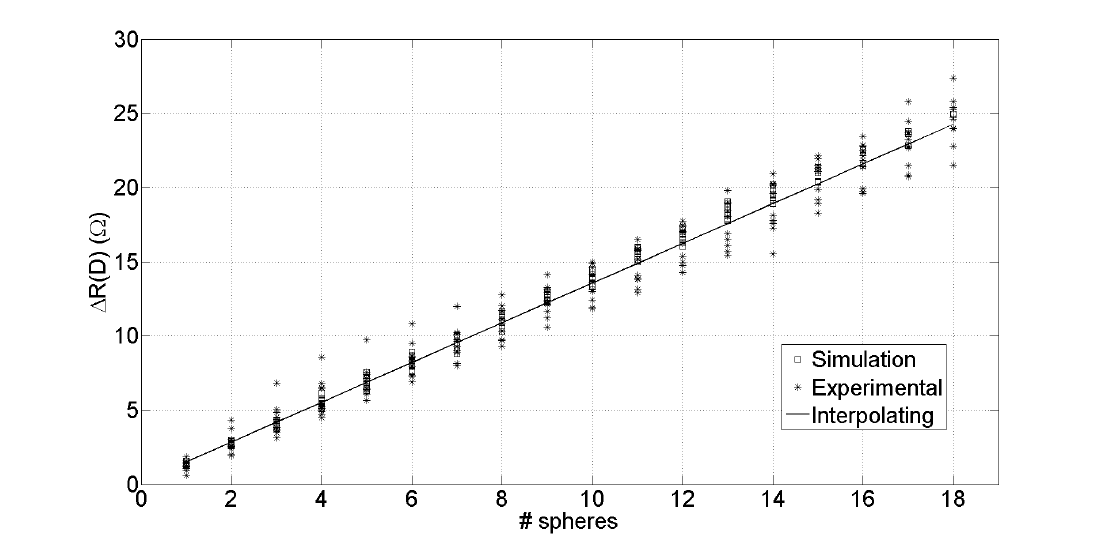
Figure 6. a) Evaluation of the quantity ∆ R ( D ) over 10 series of experiments: ( ∗ ) Simulation results, ( (cid:3) ) Experimental results, ( − ) least squares